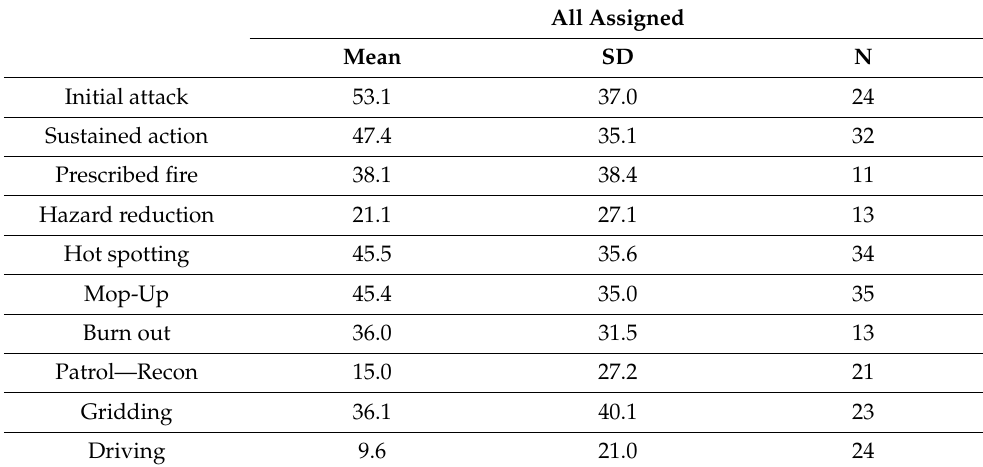
Table 5. Mask use * by task in those assigned to wear a mask and carried out the task. All Assigned Mean SD N